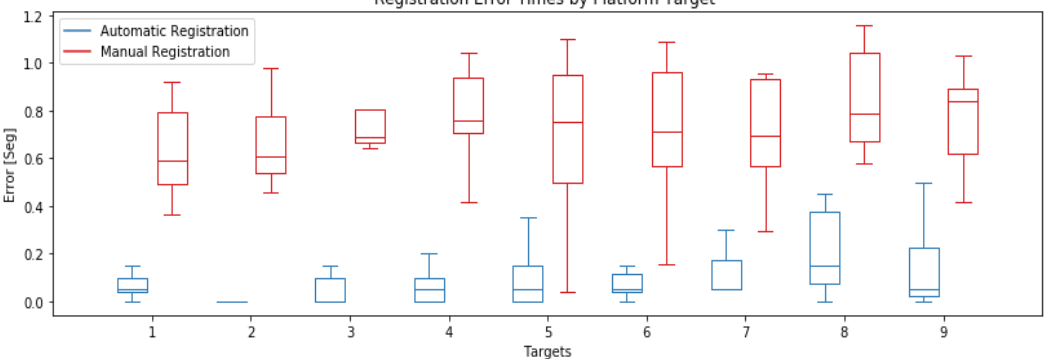
Figure 16. Boxplot of registration error times for Automatic and Manual